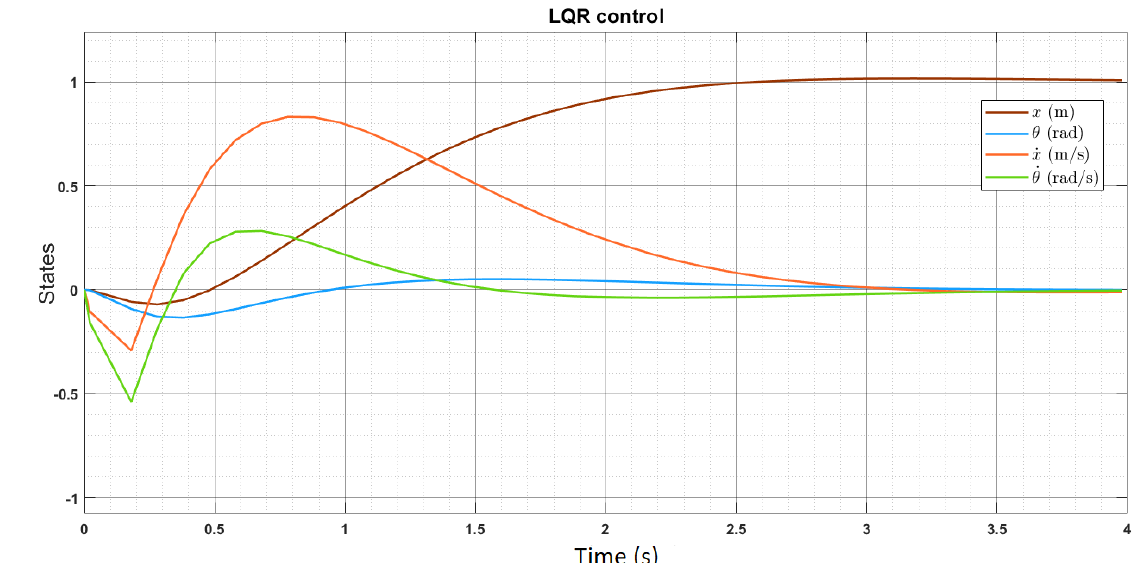
Figure 7. State responses, where x is position, θ is angle of pendulum from cart, x (cid:48) is velocity, and θ (cid:48) is angular